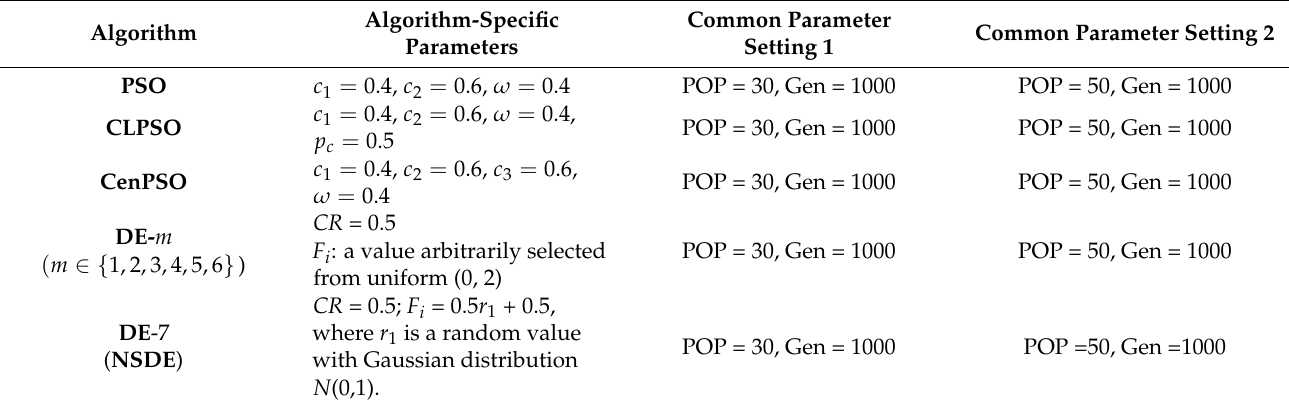
Table 11. Parameters of each algorithm. Algorithm